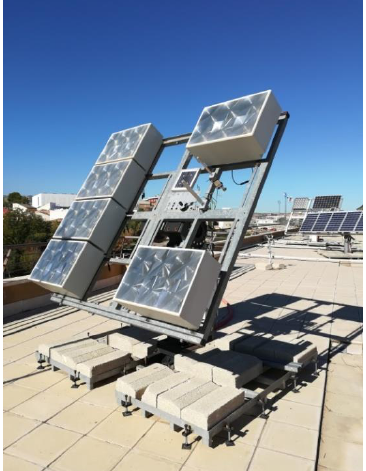
Figure 7. The designed high-concentration photovoltaic system (HCPV) tracker.